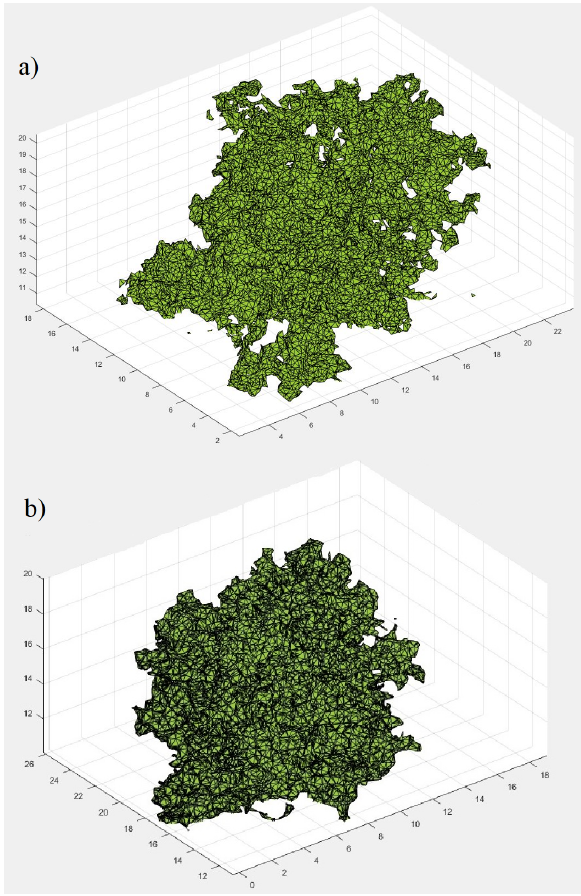
Figure 5. a) Summer canopy and b) Winter canopy reconstructed with the alpha shape ( α : 0.25) algorithm.